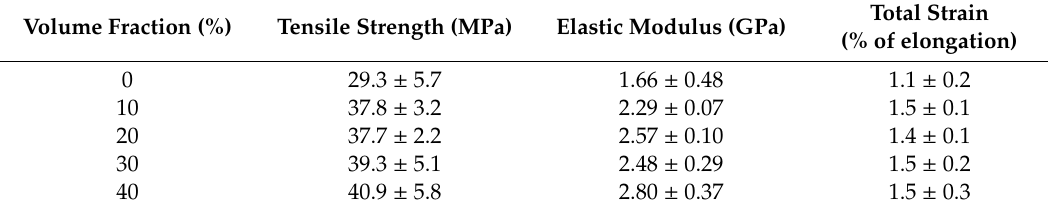
Table 2. Mechanical properties for the epoxy resin and carnauba fibers reinforced composites.